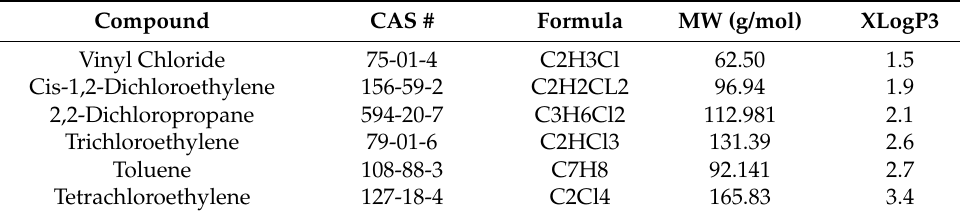
Table 1. Summary of physio-chemical properties of selected